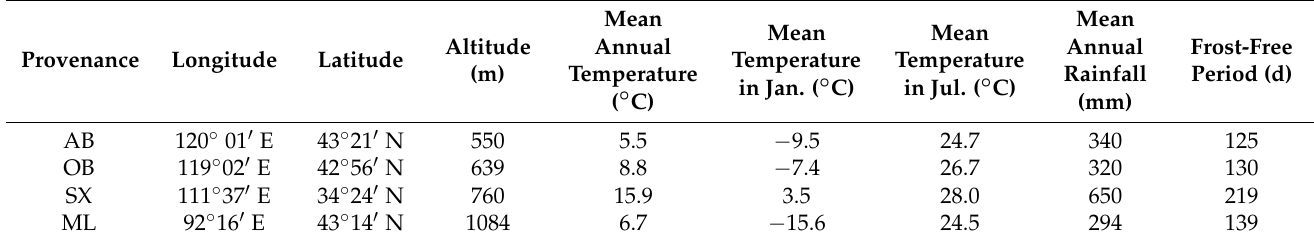
Table 1. Geographical location and climatic factors of four X. sorbifolium